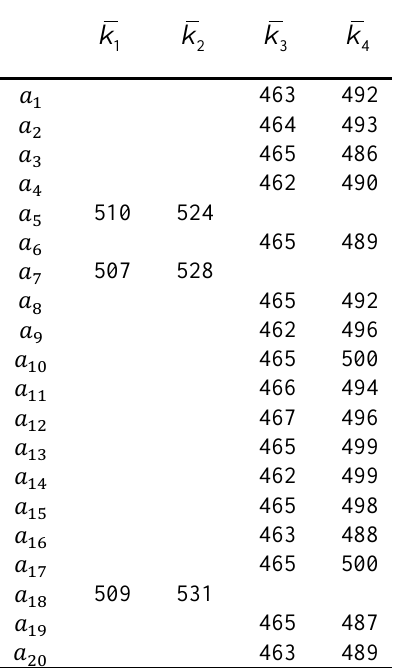
Table 2. Average time to receive orders on the market on an ordinary and overtime day for non- experienced and experienced